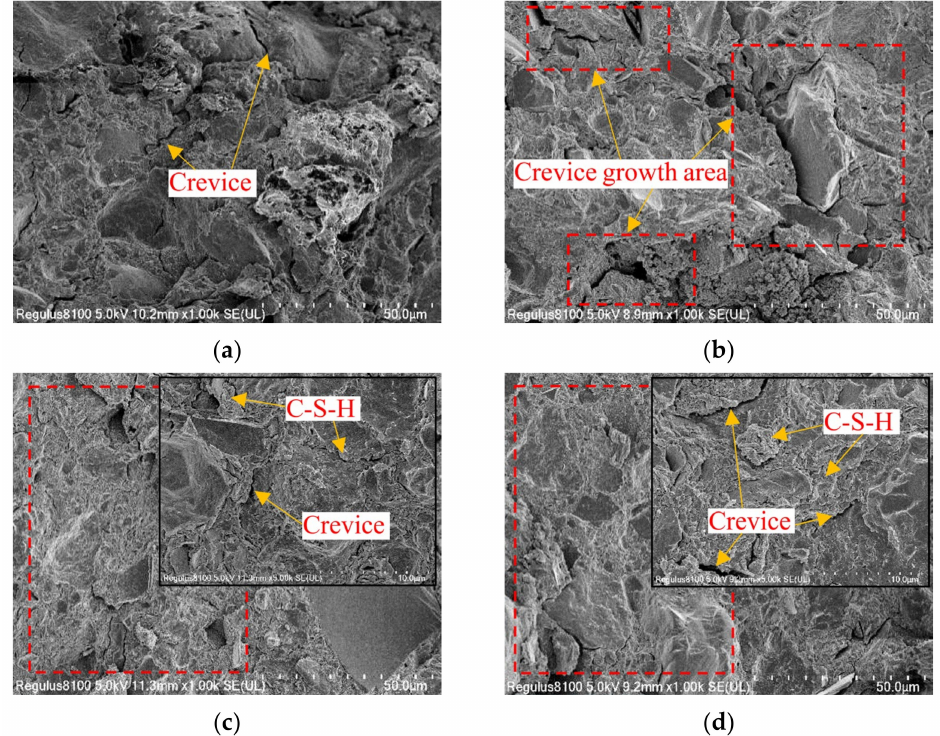
Figure 13. SEM images of LC-0 specimens and LC-12 specimens: ( a ) 0 freeze–thaw cycles of LC-0 specimens; ( b ) 4 freeze–thaw cycles of LC-0 specimens; ( c ) 0 freeze–thaw cycles of LC-12 specimens; ( d ) 4 freeze–thaw cycles of LC-12